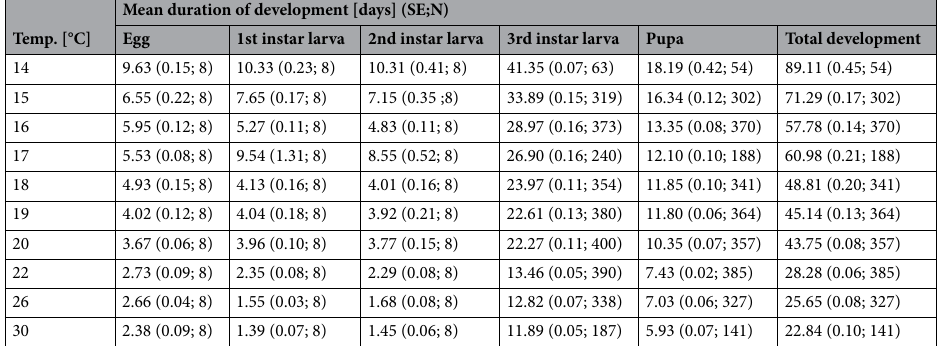
Table. 2.. Duration of immature developmental stages of N. littoralis at ten constant